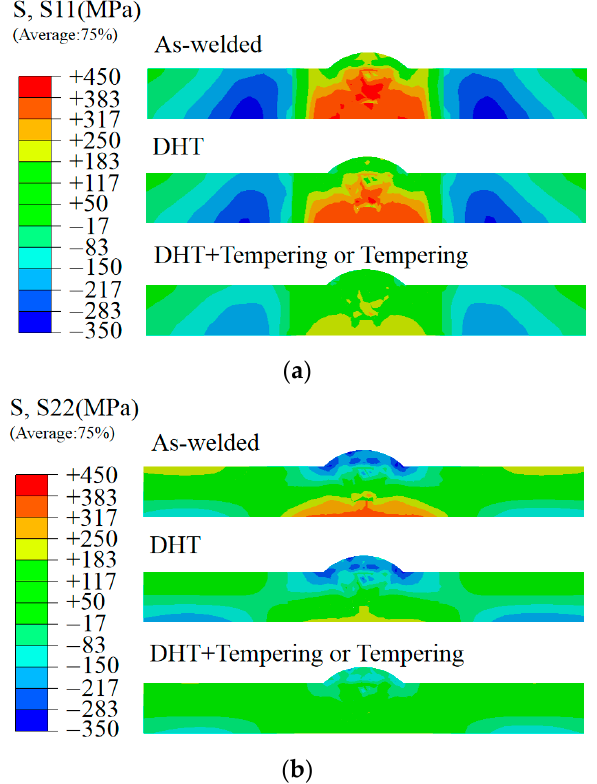
Figure 11. Comparison of residual stress distributions in condition of “as-welded”, “Dehydrogenation heat treatment” and “Tempering heat treatment”: ( a ) S11 and ( b ) S22.